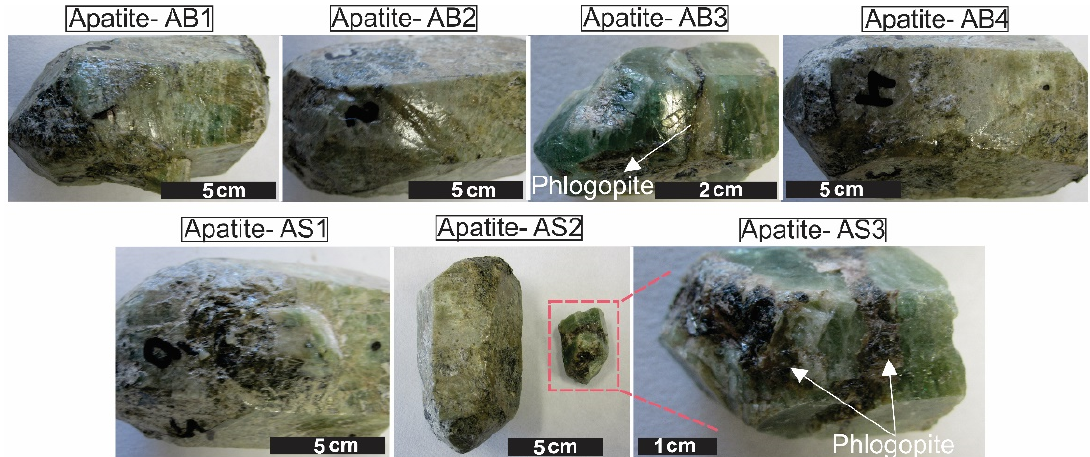
Figure 5. Separated apatite grains from the Ghareh Bagh mica mine. All apatite crystals have pyramidal shapes, appear in green color and grow till 12 cm. They are in the paragenesis of phlogopite.